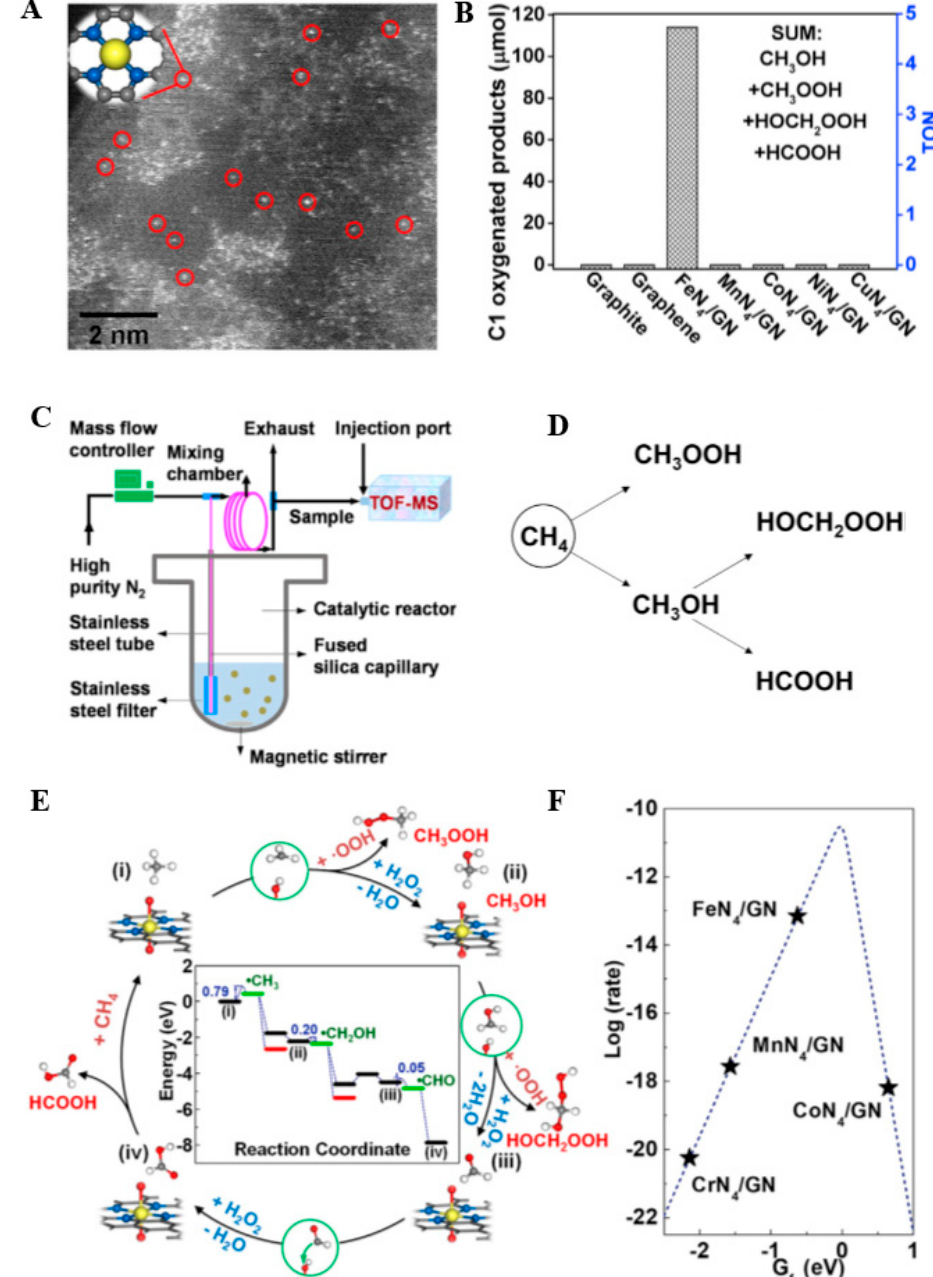
Figure 12. ( A ) High-angle annular dark-field scanning transmission electron microscopy (HAADF-STEM) image of FeN 4 /GN with the model of FeN 4 /GN in the upper left. ( B ) Different catalysts for CH 4 oxidation at 25 ◦ C. ( C ) Scheme of operando TOF-MS online connected with high-pressure reactor. ( D ) Possible reaction path for CH 4 oxidation over FeN 4 /GN catalyst. ( E ) Reaction pathway of CH 4 conversion to CH 3 OH, CH 3 OOH, HOCH 2 OOH and HCOOH (the energy of reaction initiation was set as 0 eV) as well as reactants (black), intermediates (blue), products (green and red) and the activation energy of each step (unit, eV). ( F ) The relationship between CH 4 activation rate (log[rate]) and formation energy of the O–MN 4 –O active site (Gf) presents a volcano curve. The Gf and activation rate of the calculated O–CrN 4 –O, O–MnN 4 –O, O–FeN 4 –O, and O–CoN 4 –O structures are shown on the volcano marked by black stars. Reproduced with permission from [10]. Copyright 2018 Cell press.